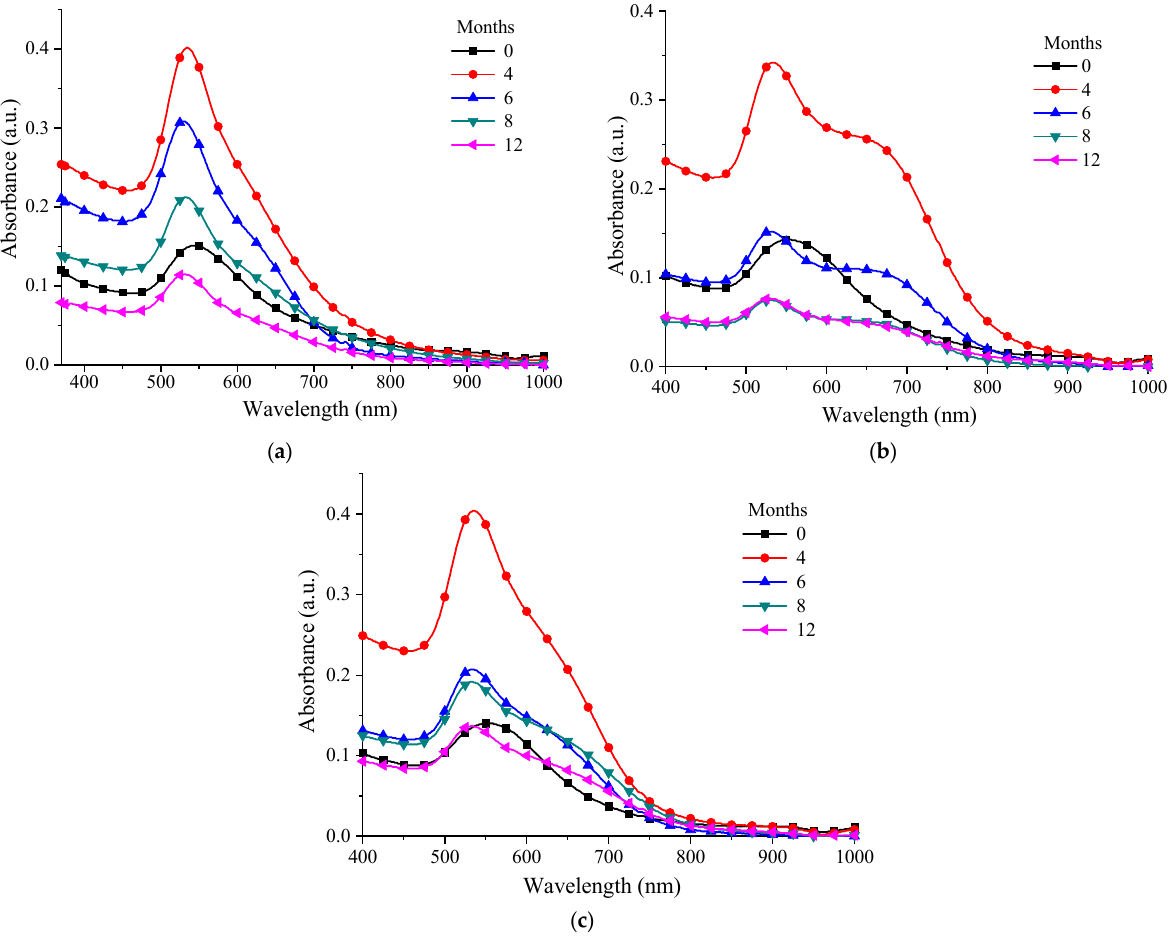
Figure 8. UV-Vis spectra over time for: ( a ) P 0.12; ( b ) M 0.12; ( c ) L 0.12.